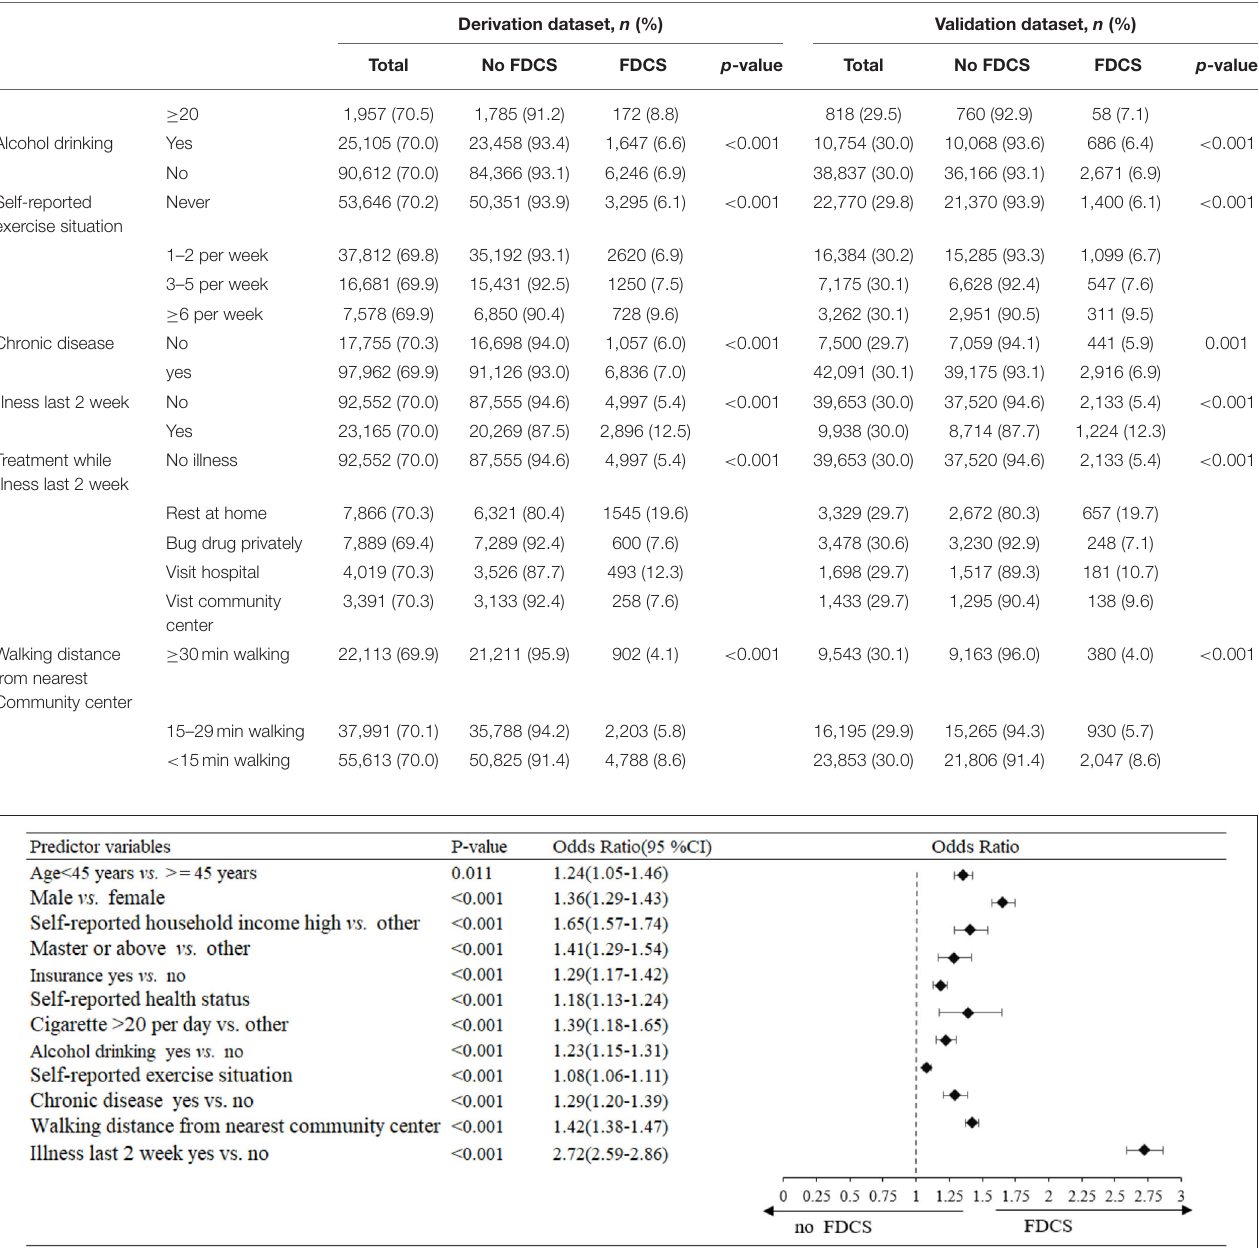
factor to the point axis. The sum of all the points from all the predictors was then used to generate the total points.